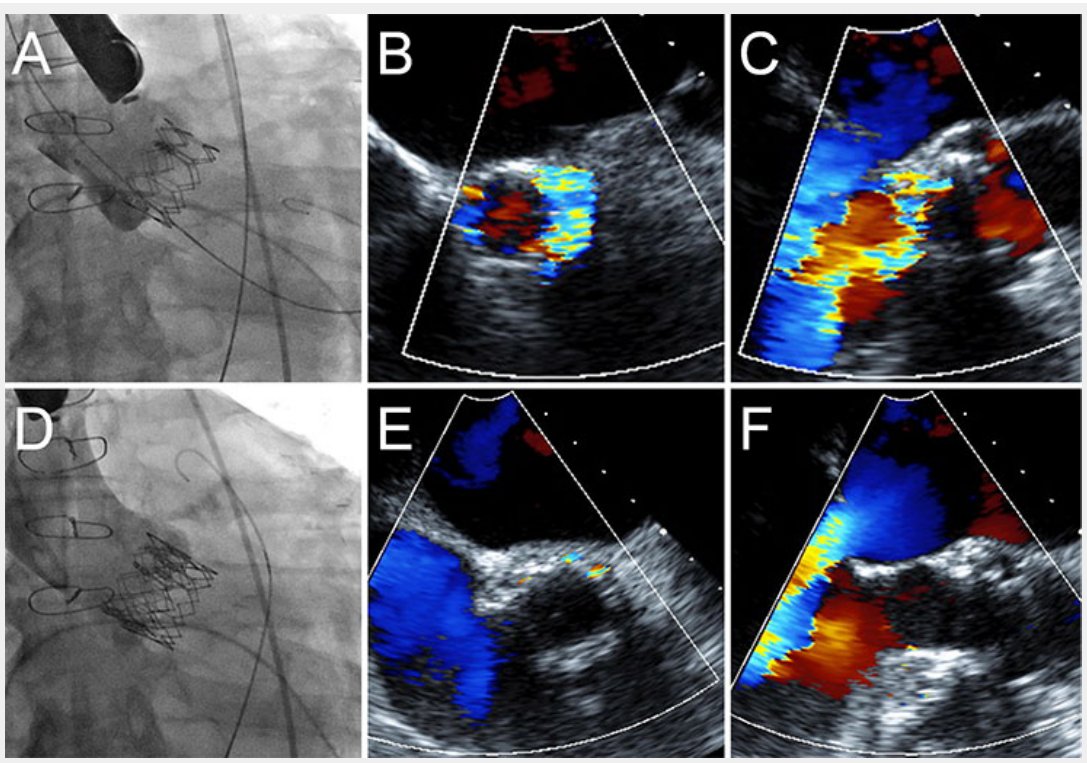
Figure 2 Treatment of paravalvular regurgitation by implantation of a second transcatheter heart valve. In patient, the TEE measured an annulus of 22 mm. A 26 mm Edwards Sapien XT valve was implanted (A). A low implantation resulted in severe paravalvular aortic regurgitation (B, C). A second 26 mm valve was subsequently implanted in a higher position, thus extending the annular seal (D) resulting in a mild paravalvular leak (E,